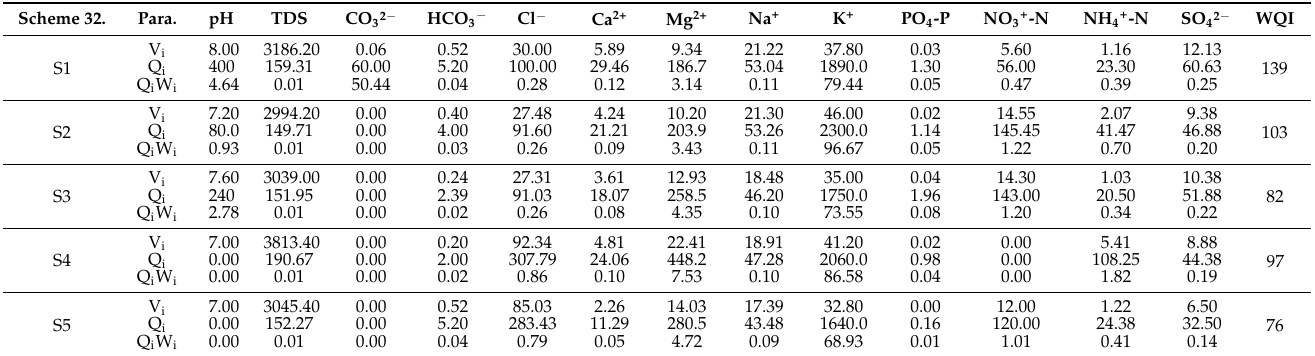
Table 6. The values of the physicochemical parameters and the WQI values in all the groundwa- ter